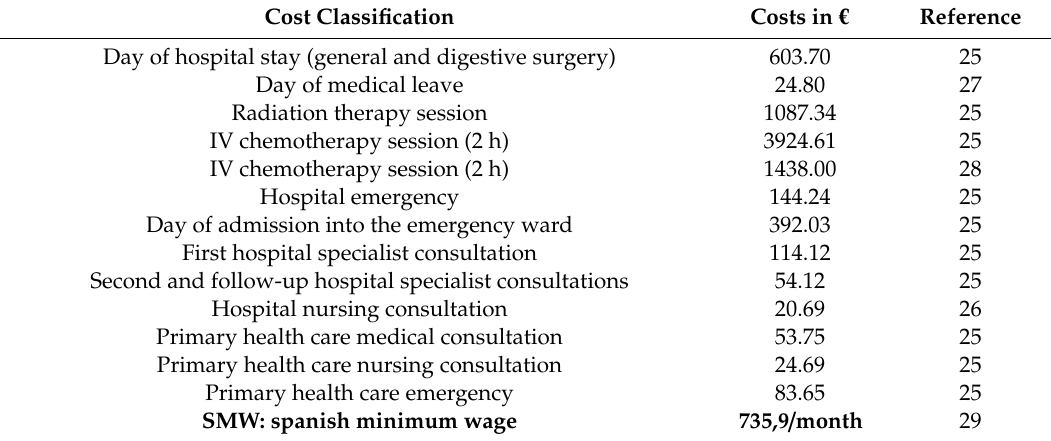
Table 1. Costs used in the